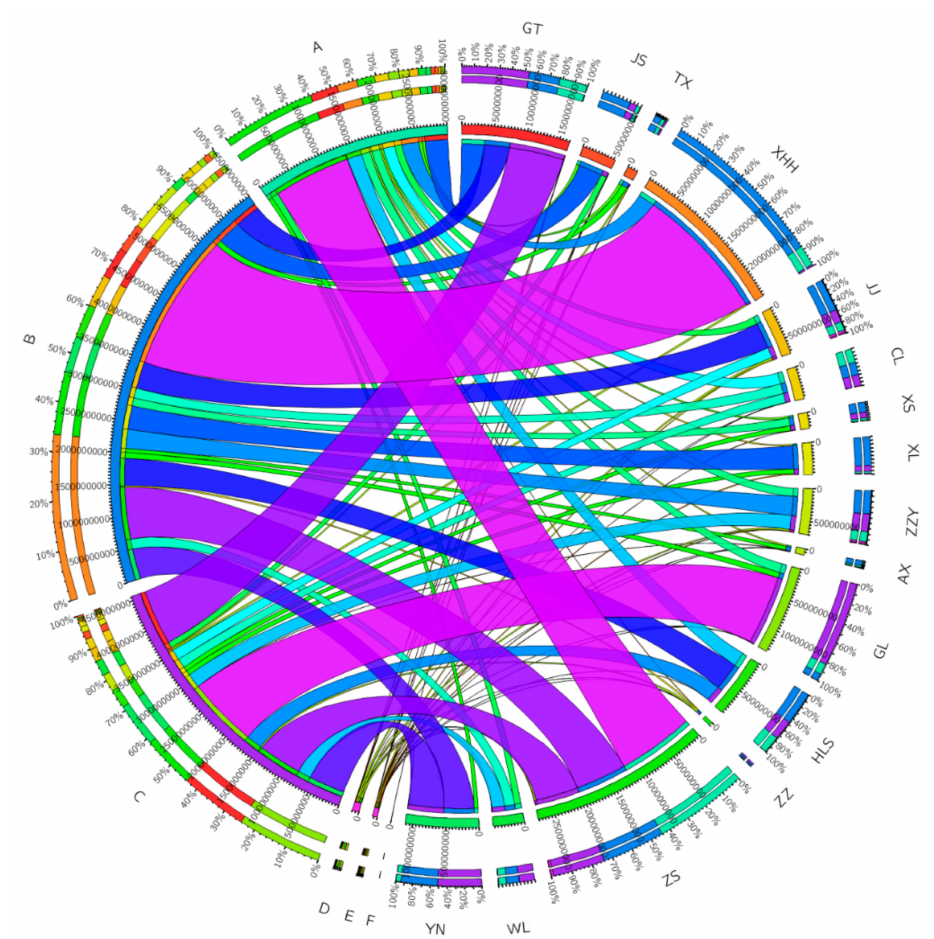
Figure 3. Circos representation of algal community at phyla level. The bands in the same urban lakes with di ff erent colors demonstratethe source of di ff erent phyla. ( A ) Chlorophyta, ( B ) Bacillariophyta, ( C ) Cyanophyta, ( D ) Dinophyta, ( E ) Euglenophyta, ( F ) Cryptophyta. The data were visualized via Circos software (http: // circos.ca /